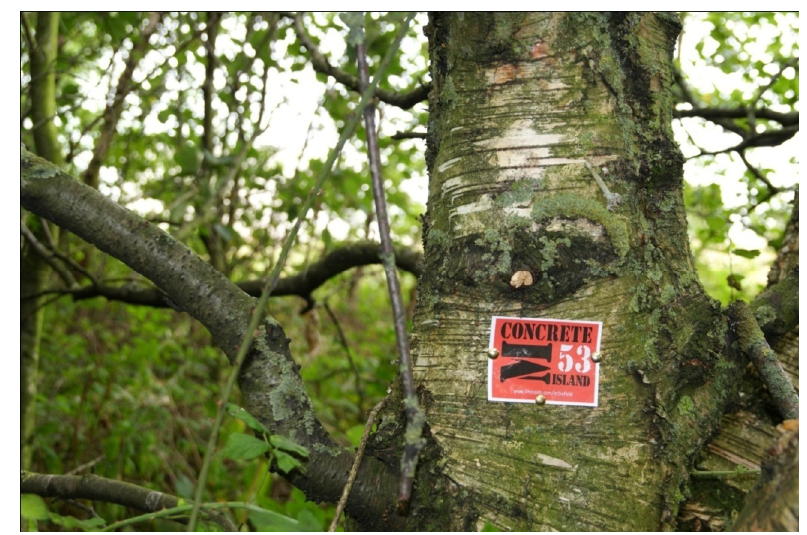
Figure 20. “Concrete Island” project